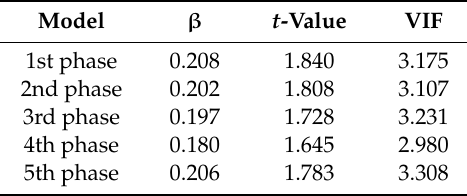
Table 7. Regression analysis between independent variables. (1st phase, 2nd phase, 3rd phase,